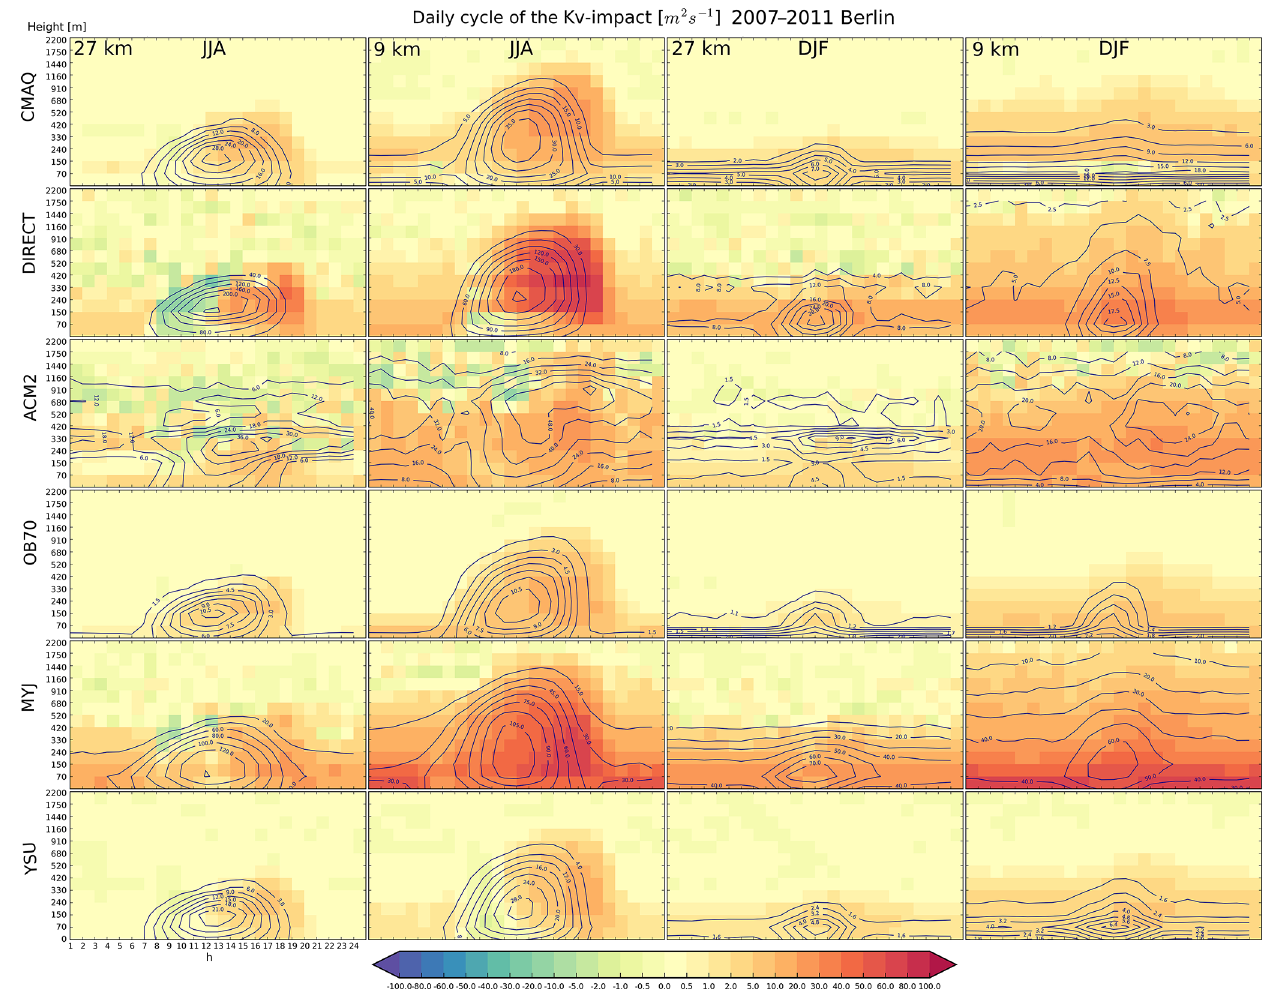
Figure 15. Impact of urban surfaces on the diurnal cycle of the vertical eddy diffusion profile in m 2 s − 1 over Berlin for the 27km (columns 1 and 3) and 9km (columns 2 and 4) domains for both seasons (columns 1–2 for JJA, columns 3–4 for DJF). Individual rows represent different K v methods (CMAQ, DIRECT, ACM2, OB70, MYJ and YSU, from top to bottom). Contour lines denote the absolute K v values from the URBAN model